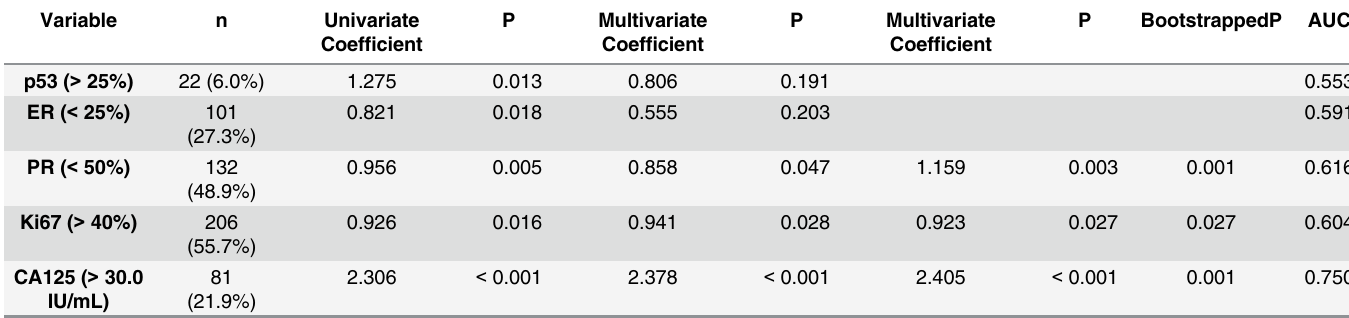
Table 4. Results of univariate and multivariate logistic regression analyses in the prediction cohort.